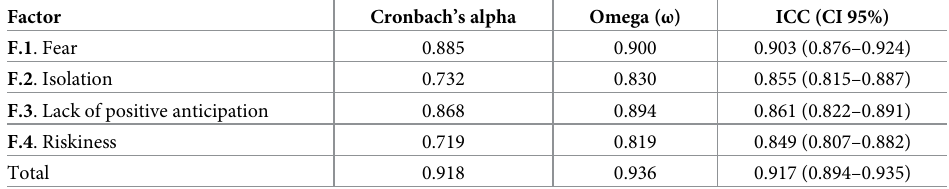
Table 7. W-DEQ-A-Sp Cronbach’s alpha coefficient, omega coefficient and ICC test-retest (n =